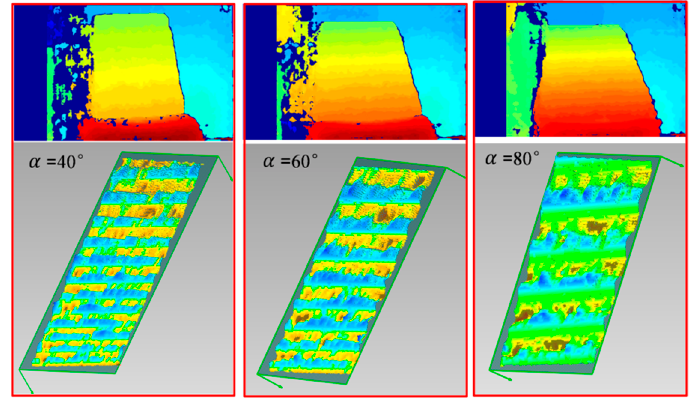
ff ect of SGM for slanted surfaces with di ff erent tilt angles. Figure 8. Ladder effect of SGM for slanted surfaces with different tilt angles. Figure 8. Ladder e Therefore, we adapted the traditional SGM algorithm to accommodate this new